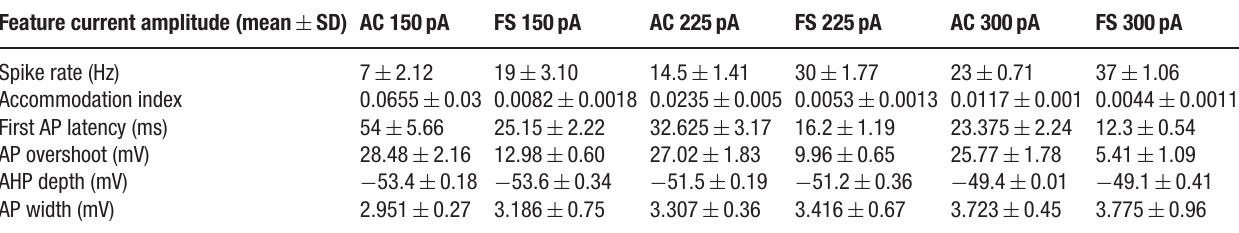
Table 1 . Feature-based error targets for accommodating (AC) and fast spiking (FS) cortical interneurons.